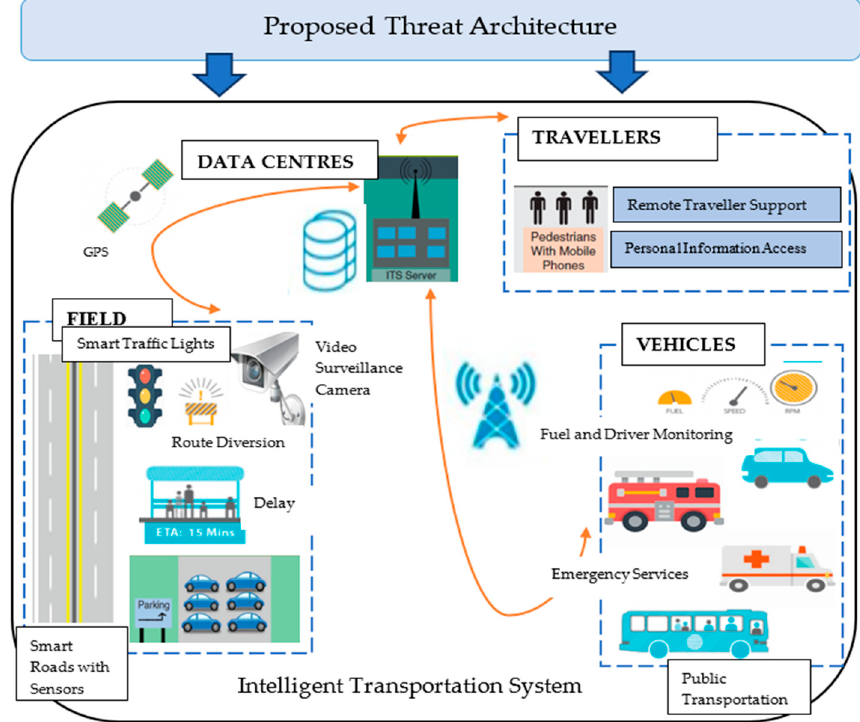
Figure 6. ITS with Proposed Threat Architecture [41–52].